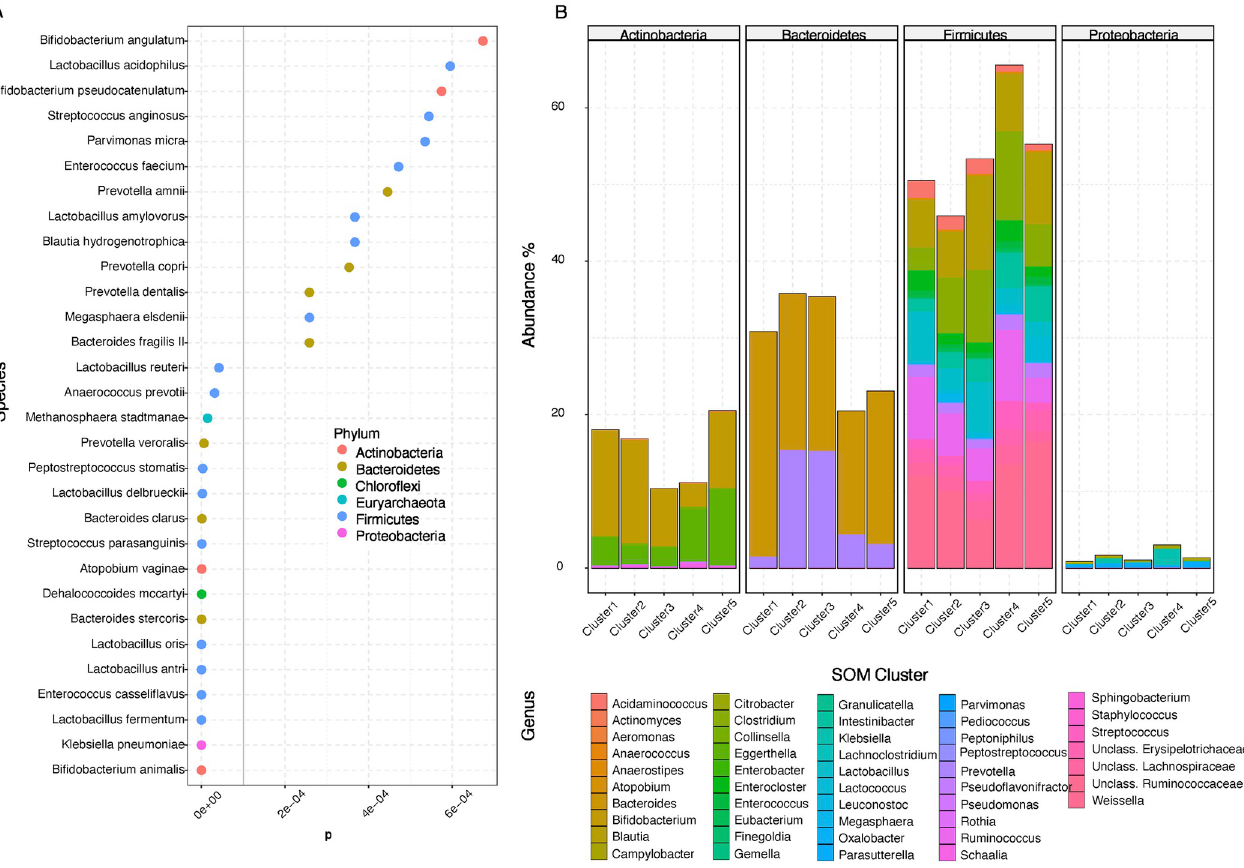
Fig 4. Differentially significant microbial species and phyla among the five defined SOM clusters (metabotypes). (A) Top 30 from 119 differentially significant microbial species among the SOM & k-means defined clusters, after differential analysis with DESeq2 ( P < 0 . 05 ). (B) Relative abundance and distribution of differentially significant microbial species for the top 4 most abundant phyla for SOM & k-means defined clusters.